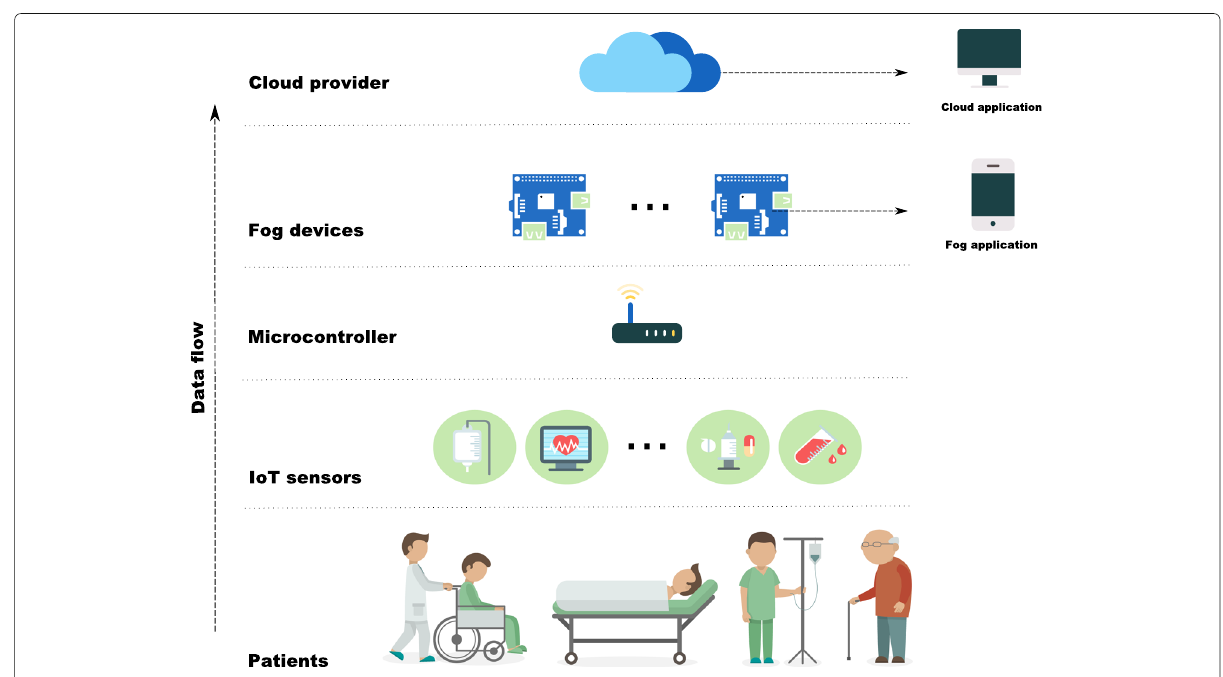
Fig. 3 An e-health monitoring system